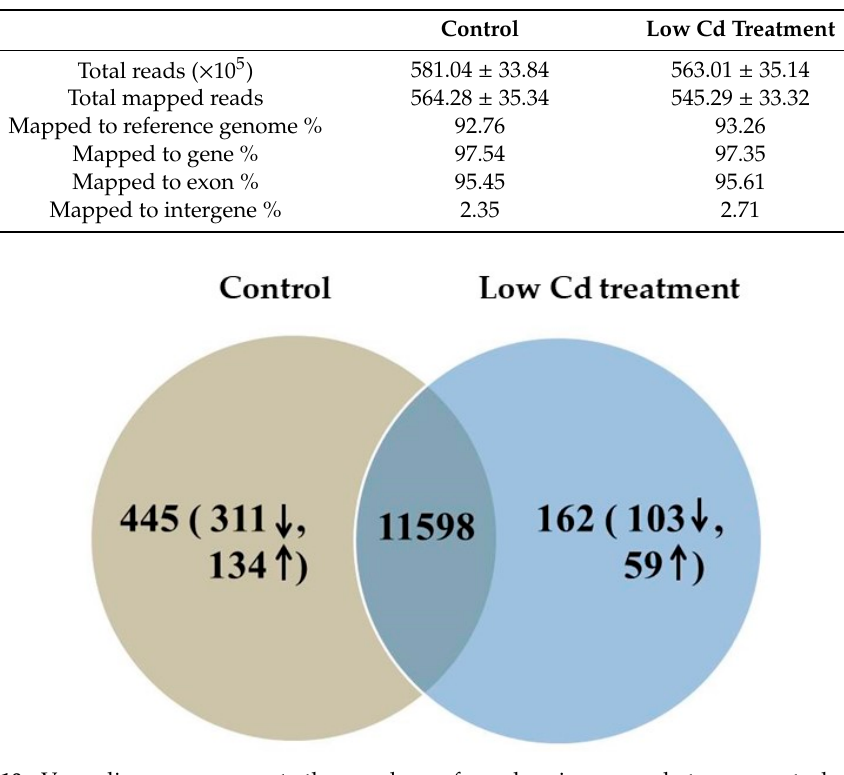
Figure 10. Venn diagram represents the numbers of overlapping genes between control and Low Cd